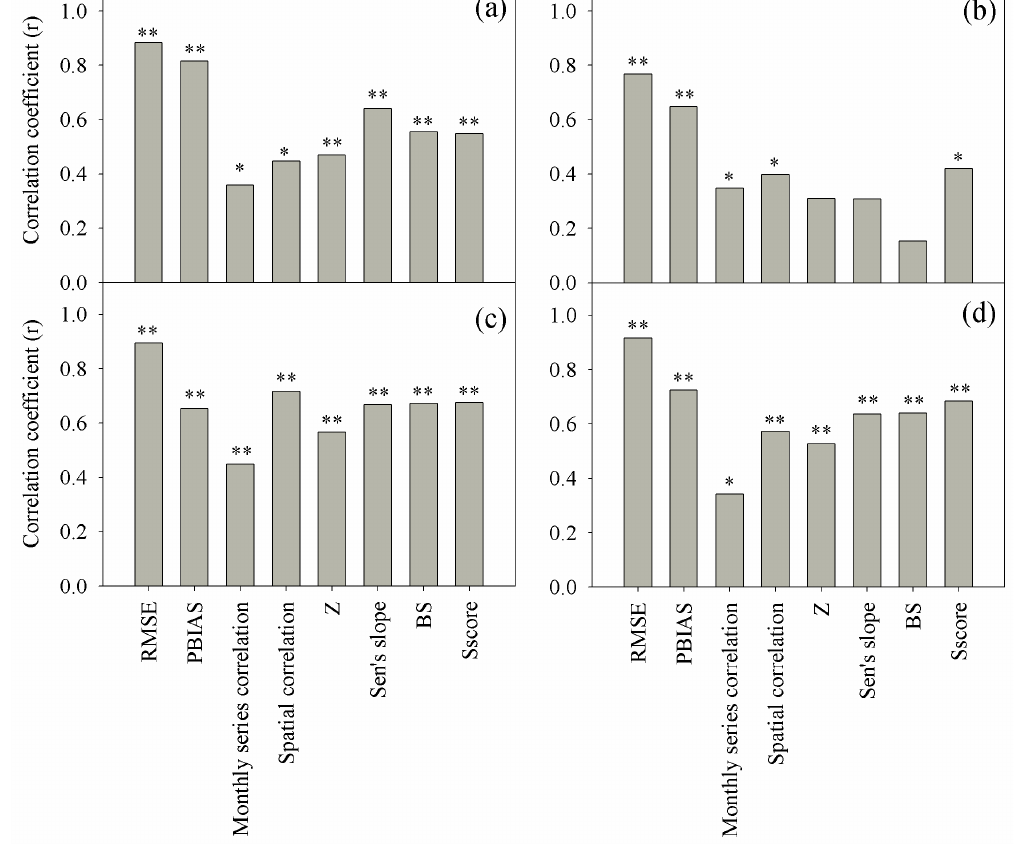
Figure 9. Correlation between ranking scores of the GCMs obtained from multiple criteria and ranking scores of the GCMs obtained from a single criterion over the LMB: ( a ), ( b ), and ( c ) represent the time periods of the wet season, the dry season, and the annual time, respectively; ( d ) represents the correlation between the overall ranking scores and the weight criteria ranking scores; ** represents that correlation was significant at the 0.01 level; * represents that correlation was significant at the 0.05 level.